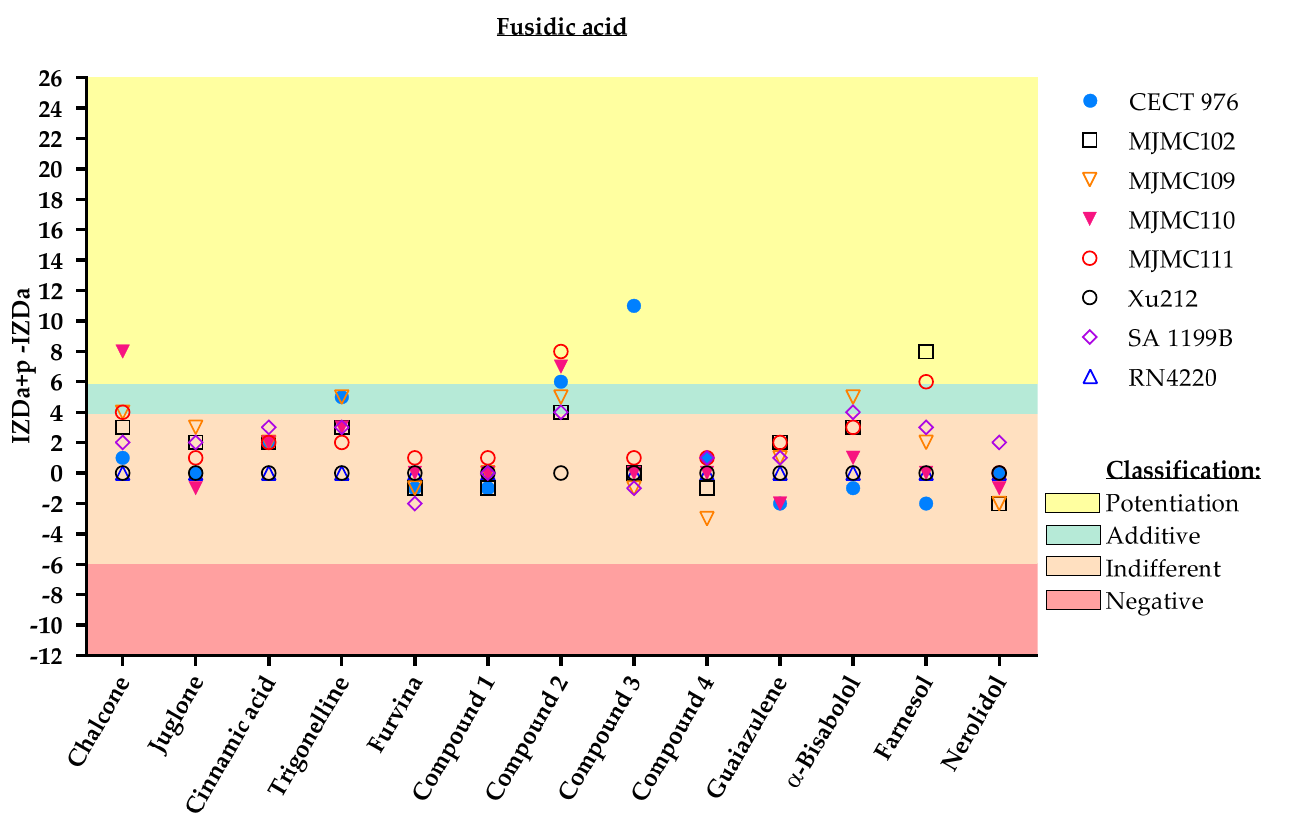
Figure 1. Inhibition zone diameter (IZD) values (mm) and respective classification according to the combined application of the selected phytochemicals and fusidic acid against the eight different S. aureus strains. The effect of dual combinations of antibiotics and phytochemicals was classified as potentiation when IZDa+p–IZDa ≥ 6 mm (yellow zone), additive when 6 mm > IZDa+p–IZDa ≥ 4 mm (green zone), indifferent when 4 mm > IZDa+p–IZDa > − 6 mm (light pink zone) and negative when IZDa+p–IZDa ≤ − 6 mm (dark pink zone), where IZD corresponds to the inhibition zone diameter, a = antibiotic and p = phytochemical. Compound 2 , a nitrovinylfuran derivative, induced total growth inhibition against the RN4220 strain. More detailed information about the interactions is given in the Supplementary Materials, including some geometric shapes that might be overlayed on the graph (Supplementary Materials Table S1).